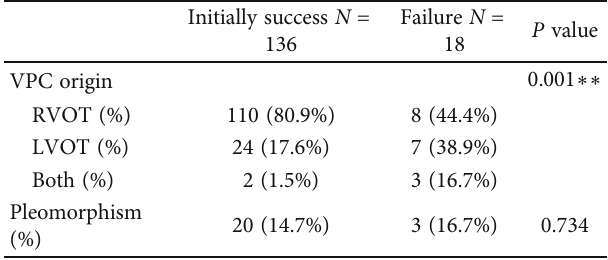
Table 2: Comparison of VPC Origin and pleomorphic VPCs in patients with initially successful and failed RFCA ( N = 154